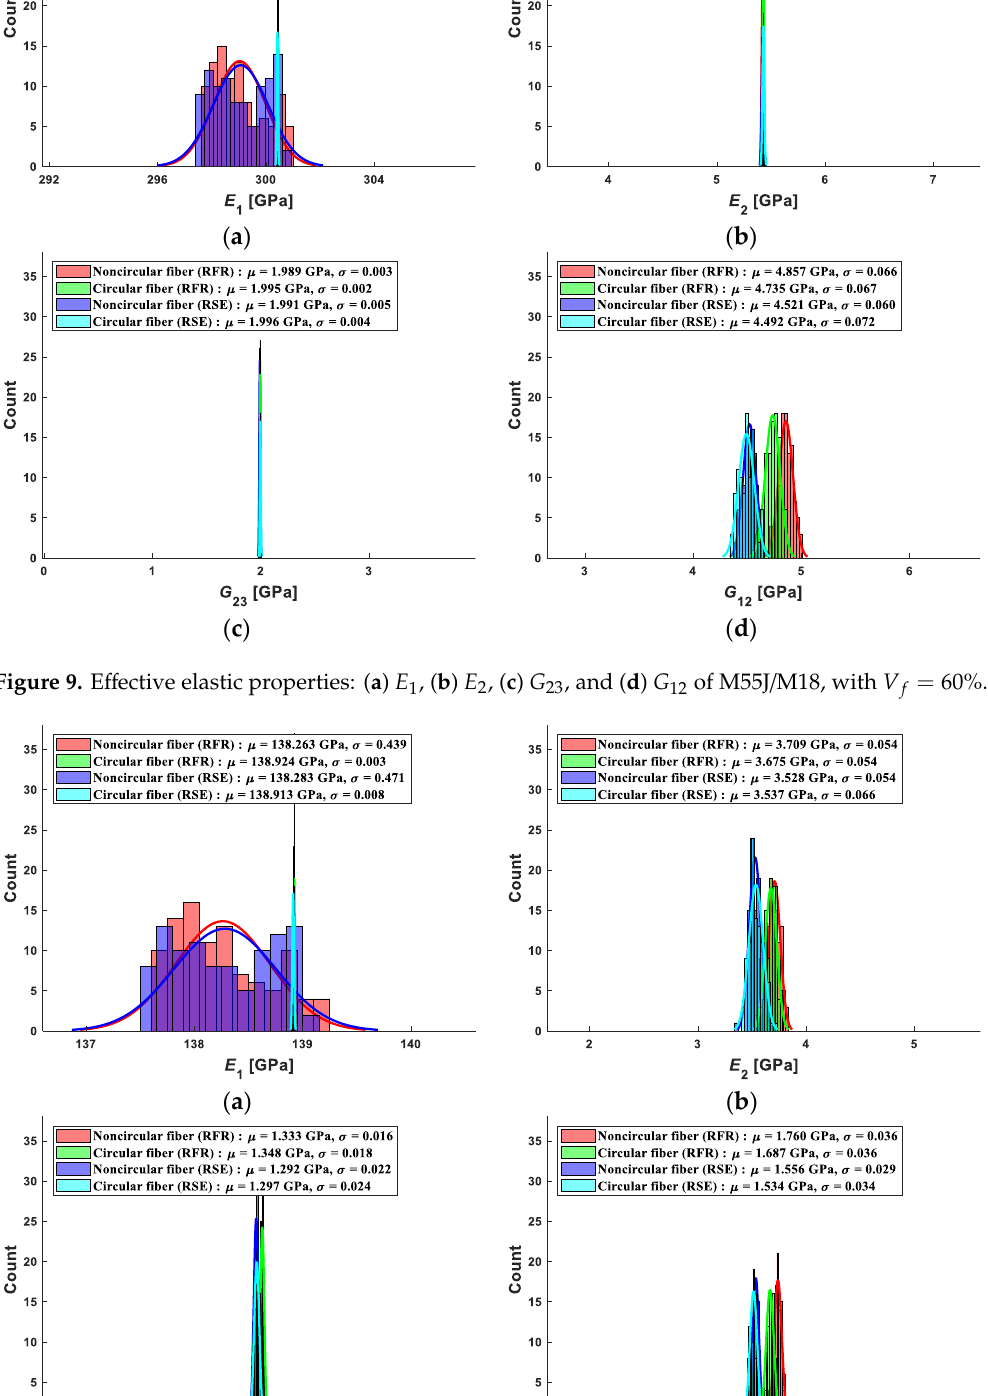
Figure 10. E ff ective elastic properties: ( a ) E 1 , ( b ) E 2 , ( c ) G 23 , and ( d ) G 12 of T300 / PR319, with V f =